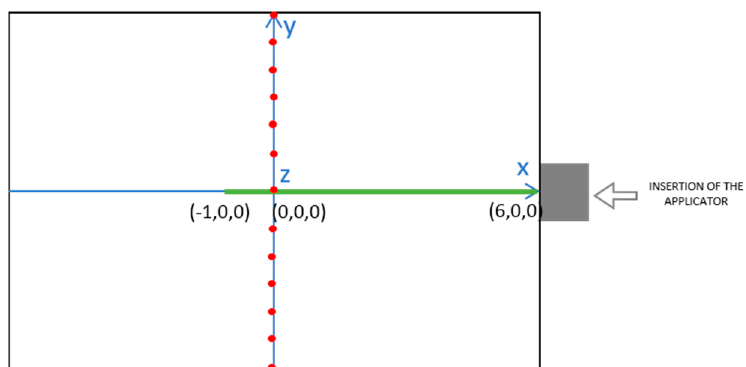
Figure 3. Positioning of the MTA applicator in the tissue specimen (green line) and MWT measurement points (red dots). View on a coronal plane at a height of about 40 mm from the applicator. Distances are expressed in cm. The blue lines denote the coordinate axes, while grey square and white arrow indicate the applicator and its insertion direction, respectively.